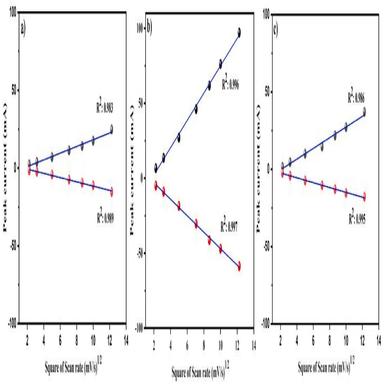
Randle-Sevick curves for (a)ZIF-8/Ni(50%)Co(17%)Al(33%)-LDH, (b) ZIF-8/Ni(33%)Co(33%)Al(33%)-LDH, and (c) ZIF-8/Ni(17%)Co(50%)Al(33%)-LDH.